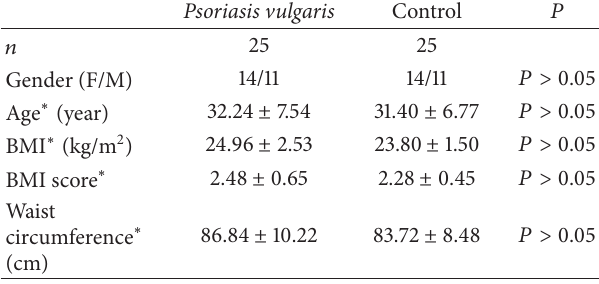
Table 1: Demographical and clinical findings of